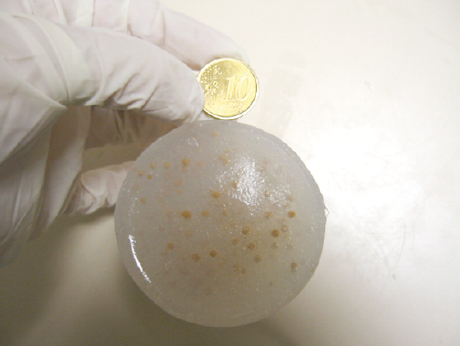
Figure 8: Test piece. Table 2: 2-D shape analysis: Area, orientation, and eccentricity descriptors of test pieces.